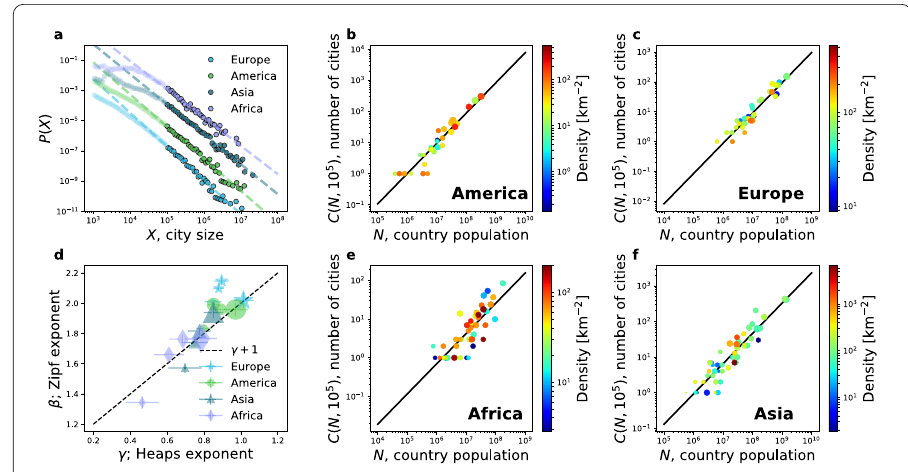
Figure 2 Heaps’ law for countries. ( a ), Zipf’s Law: PDF ( y -axis) of city sizes X ( x -axis) for all cities in Europe, America, Asia and Africa. The darker regions correspond to cities with population X > 10 5 , above which the distributions are a power law with exponent β = 1 + α given in Table 1. The dashed lines correspond to y = x – β . Distributions have been shifted in the y -axis for clarity.( b) –( c ) and ( e )–( f ), Heaps’ law for America, Europe, Africa and Asia. The following information is displayed for each country: population ( x -axis), number of cities with more than 100 k inhabitants ( y -axis), logarithm of the area (marker size) and population density (color). The black line is a power law fit of the scaling relationship between the number of cities and the total population; Heaps exponents γ are reported in Table 1. ( d ), The exponent of the Zipf PDF, β ( y -axis) and the corresponding exponent γ of Heaps’ law for Europe, America, Asia and Africa. Marker size corresponds to the minimum city population used in determining the values of γ and β : values used are 10 3 ,5 × 10 3 ,10 4 and 10 5 , where 10 3 is represented by the smallest marker and 10 5 by the largest. Increasing the minimum city population corresponds to a decrease in the amount of data used to fit γ and β : for a given continent, each point represents the same data set but restricted to a different range of X values. The black dashed line corresponds to the relationship between the exponents, β = γ +